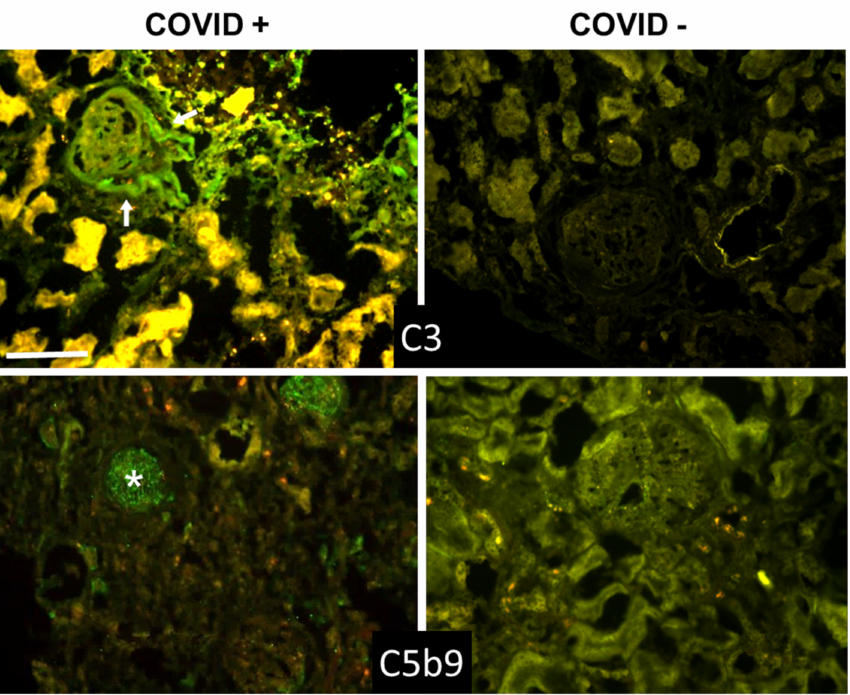
Figure 4. Detection of C3 and C5b-9 in kidney sections by immunofluorescence analysis. The